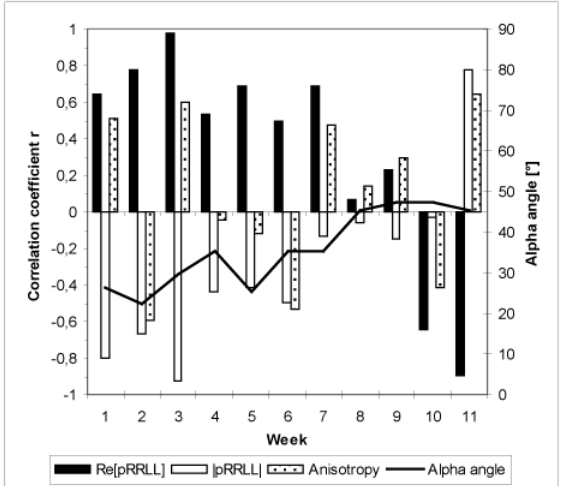
Figure 5. Correlation coefficients between roughness estimators and ks versus mean polarimetric alpha angle showing threshold for valid areas of roughness retrieval.